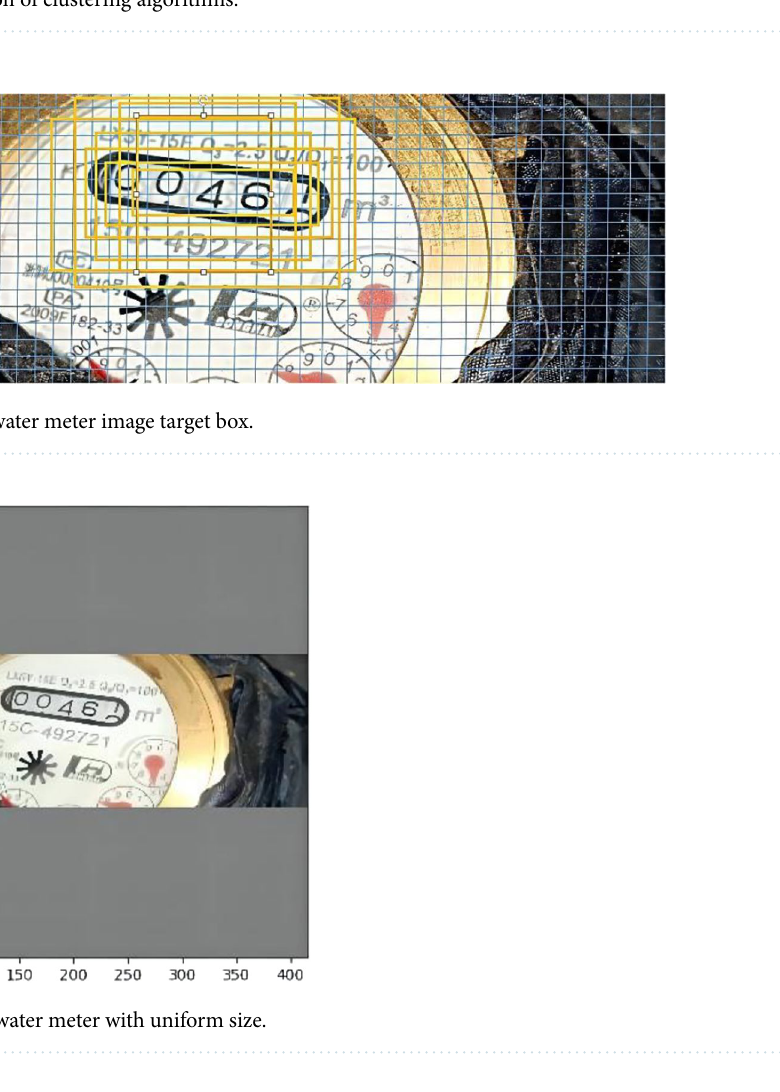
Table 1. Comparison of clustering algorithms.